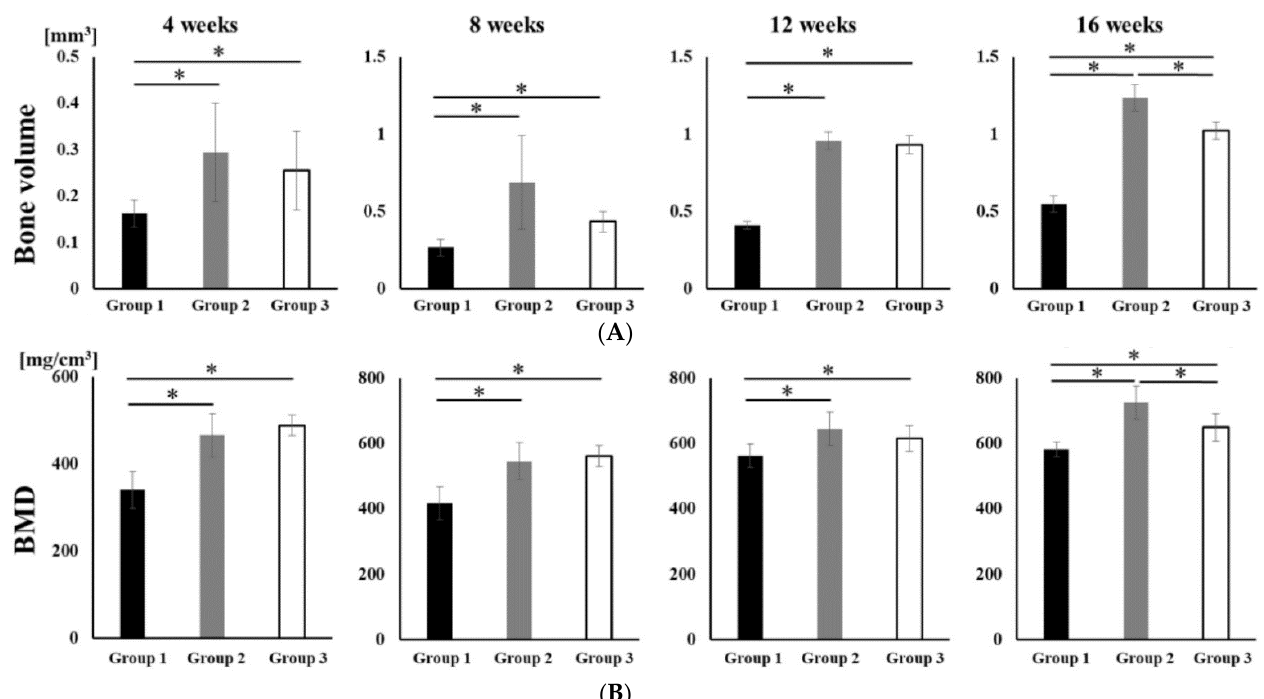
Figure 3. Micro-CT images of the maxilla immediately after grafting and at 4, 8, 12 and 16 weeks after grafting. New bone formation (arrows) at the margins of the left palatine process of the maxilla was noted on the radiographs of all samples. ( A ) Group 1 (low cross-linked RCP particles). ( B ) Group 2 (medium cross-linked RCP particles). ( C ) Group 3 (High cross- linked RCP particles). Each image shows the horizontal plane section of the maxilla in the rats.